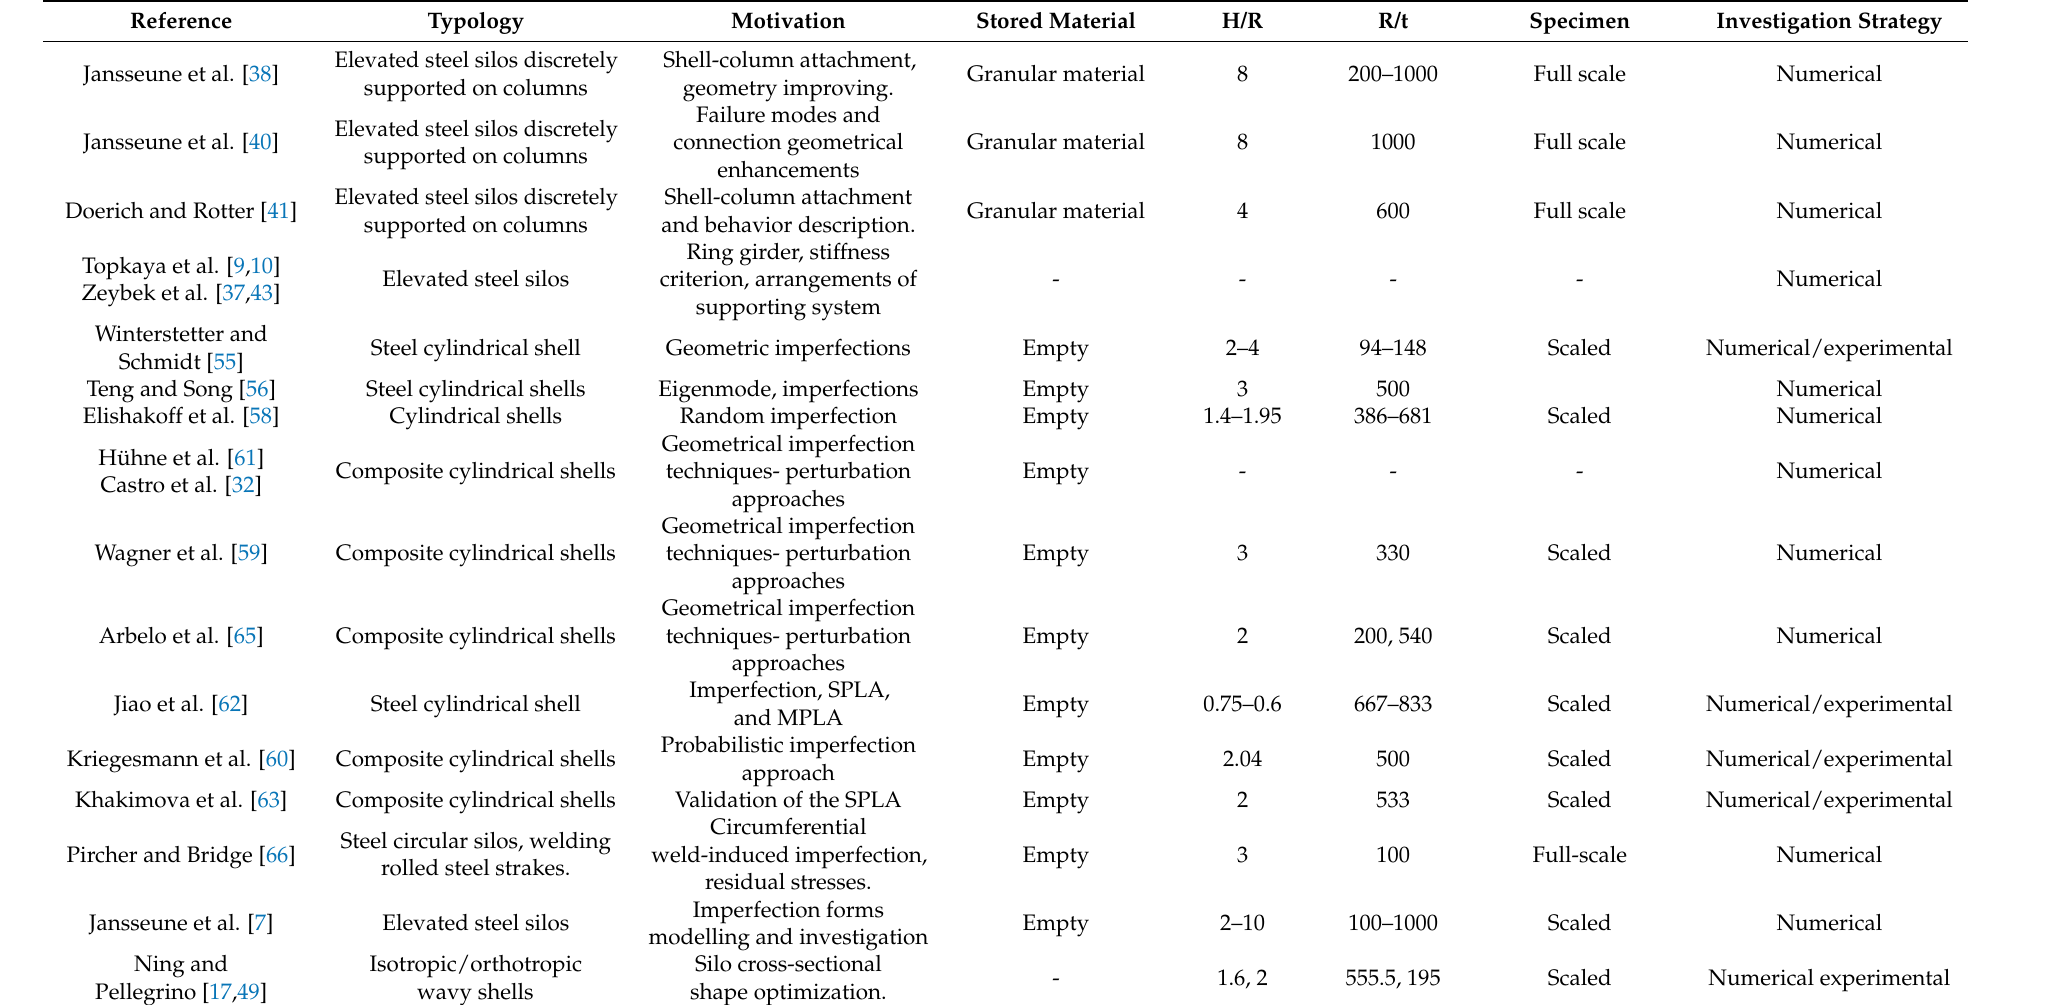
Table 1. Structural typology and arrangement of circular silos. H, R, and t indicates the height, the radius, and the thickness of the